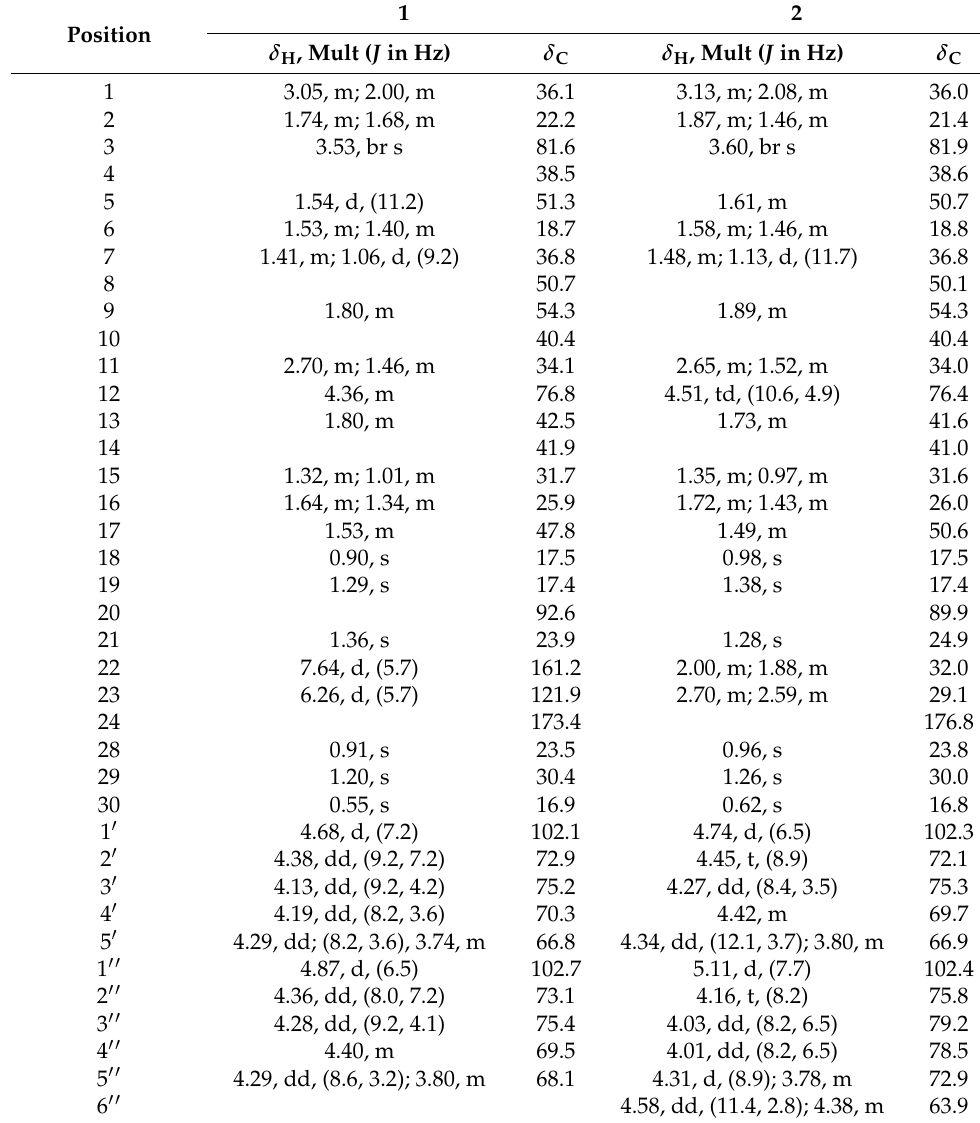
Table 1. 1 H and 13 C NMR spectral data of compounds 1 – 2 (600 MHz, Pyridine- d 5 , δ in ppm).